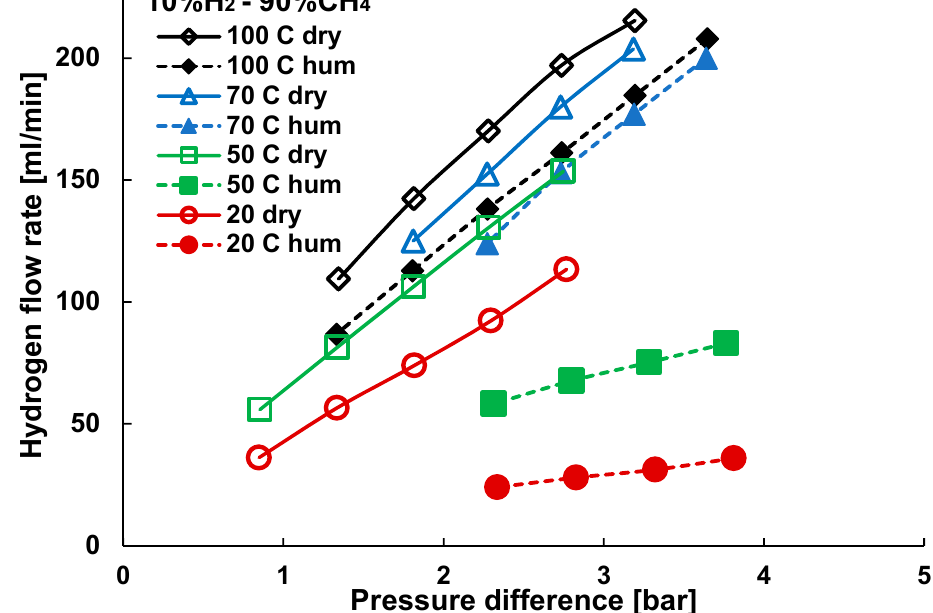
Figure 15. Comparison between hydrogen flow rate in an H 2 -CH 4 mixture with 10% hydrogen concentration at 20, 50, 70 and 100 °C in a dry and humidified membrane, for CMSM-600.